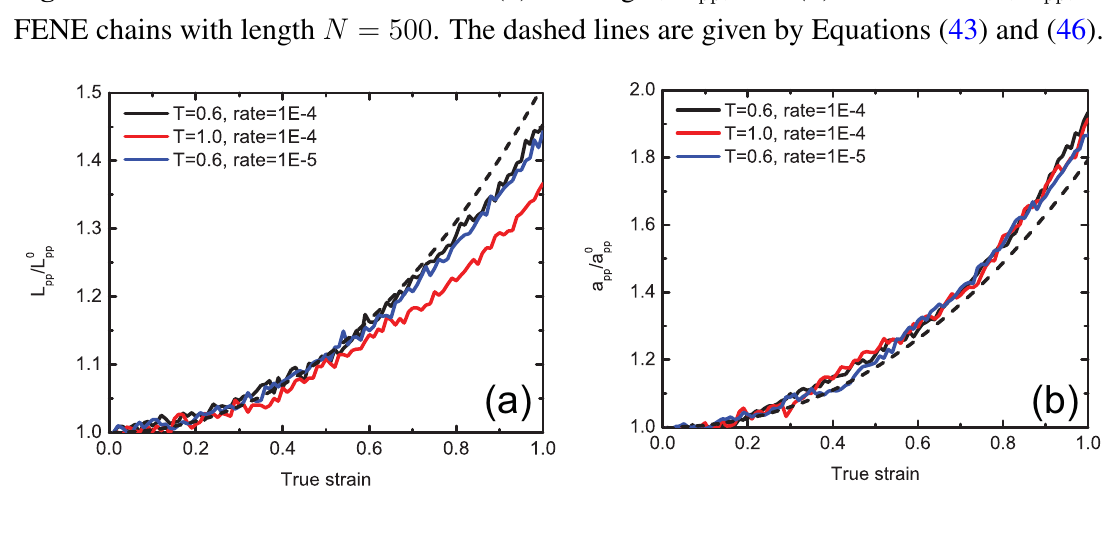
, and ( b ) tube diameter, a , of pp pp